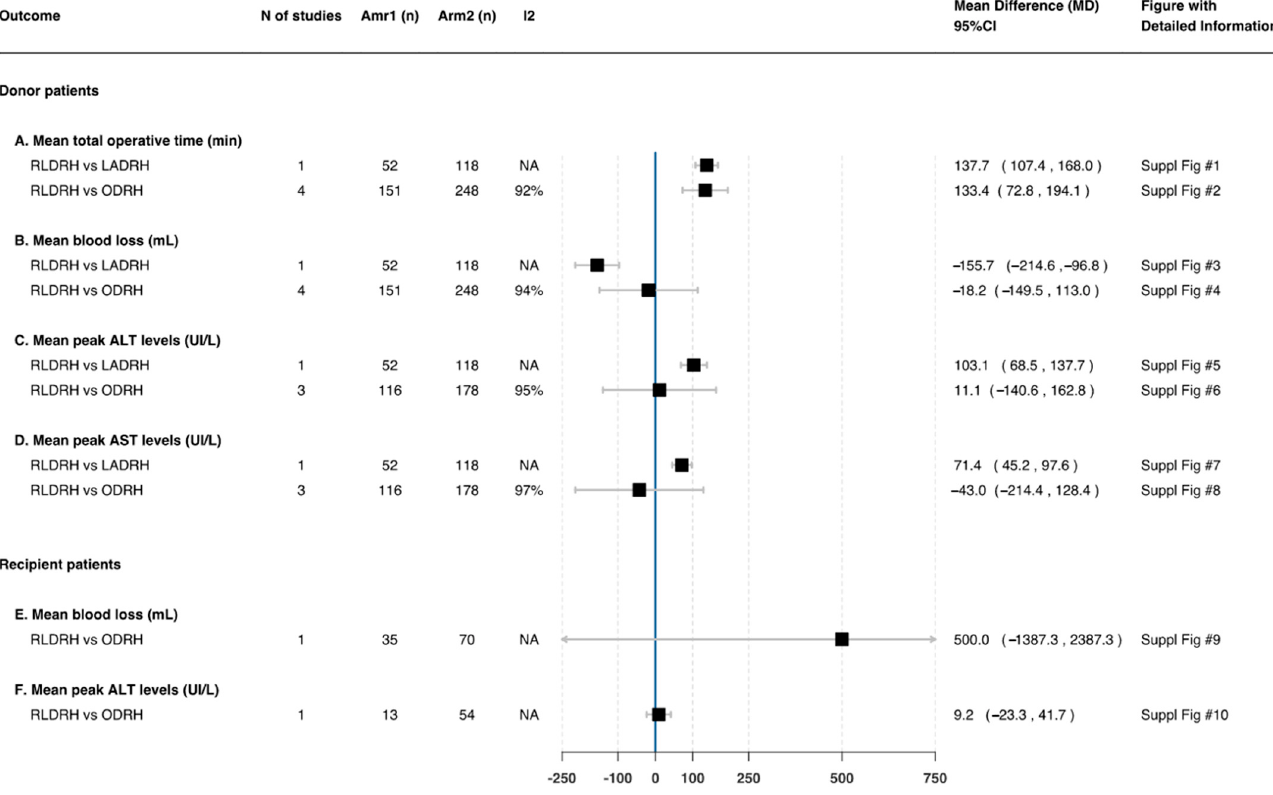
Figure 4. Mean difference in donors’ and recipients’ postoperative characteristics—part 2. Suppl figs can be found in Github, please refer to Section 2.8.